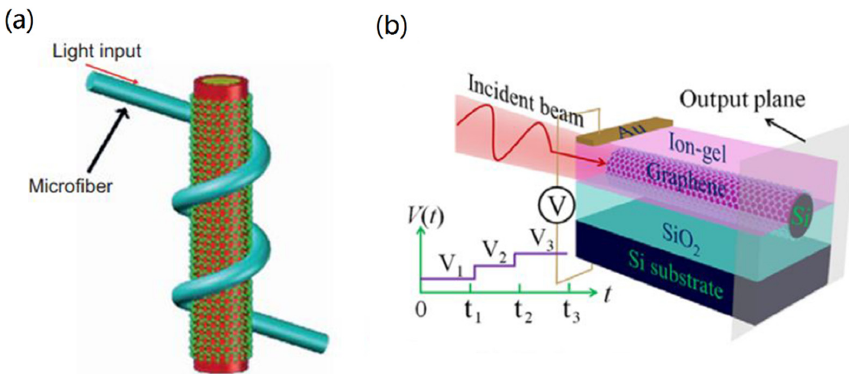
Figure 10. ( a ) A stereo graphene-coated–microfiber modulator. Reprinted with permission from